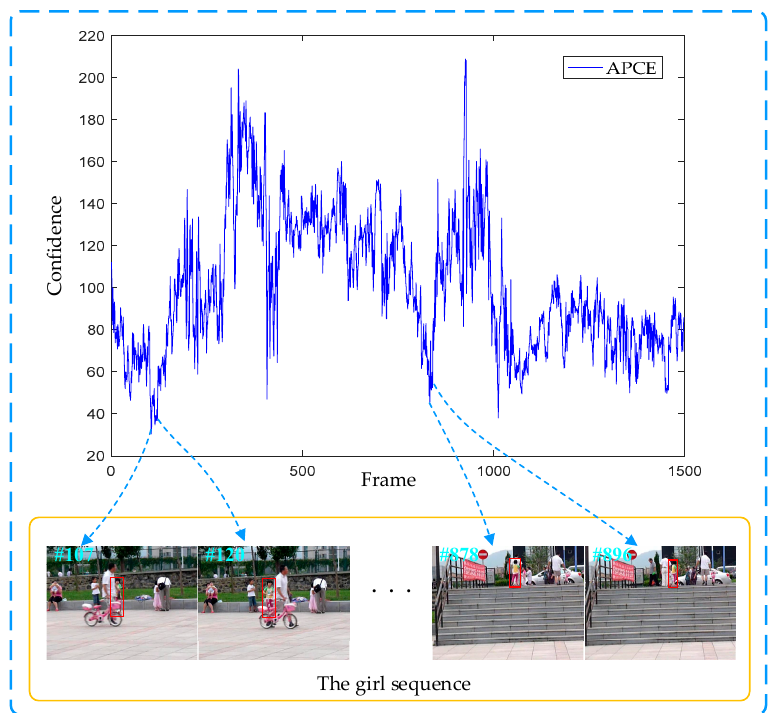
Figure 5. An example of the average correlation peak energy (APCE) being sensitive to the visual tracking environment on the girl sequence in the VOT2016 dataset.